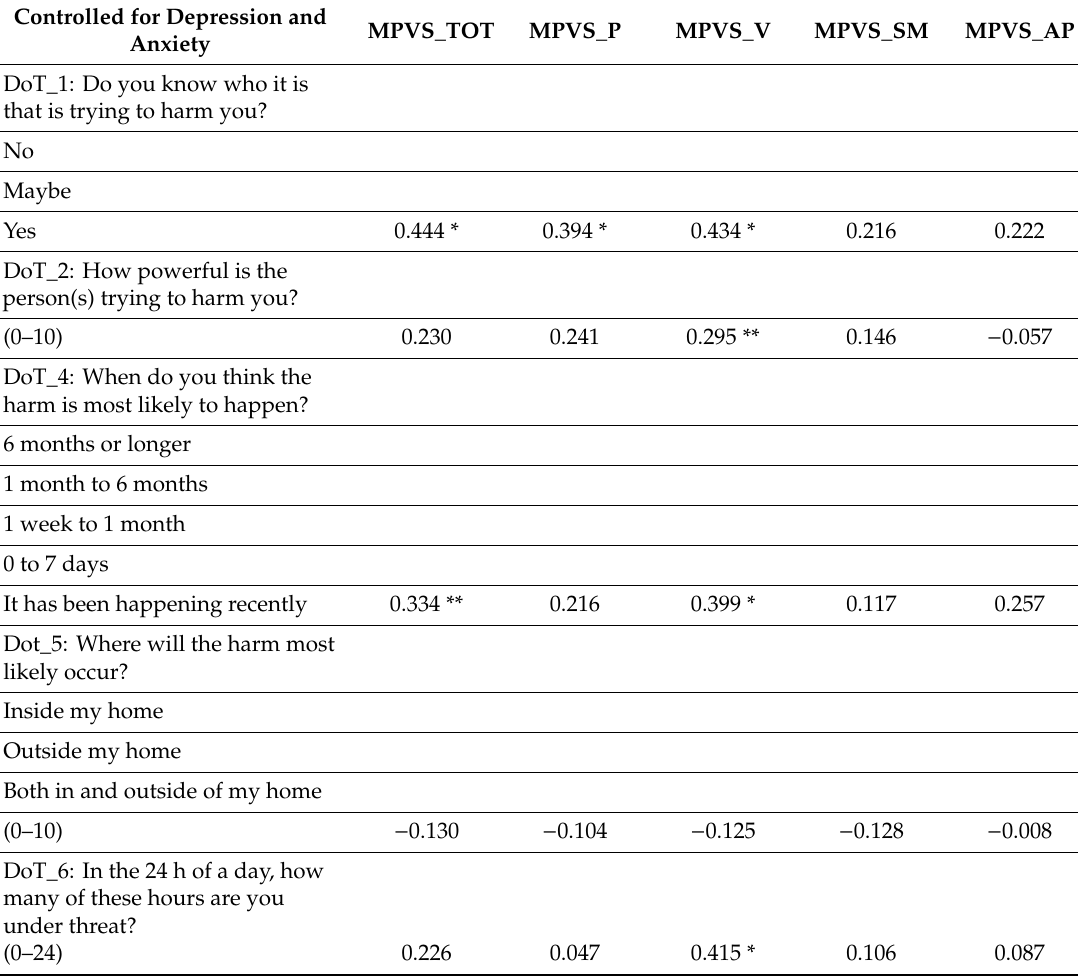
Table 3. Partial correlation between the contents of paranoid thoughts and bullying victimization. Controlled for Depression